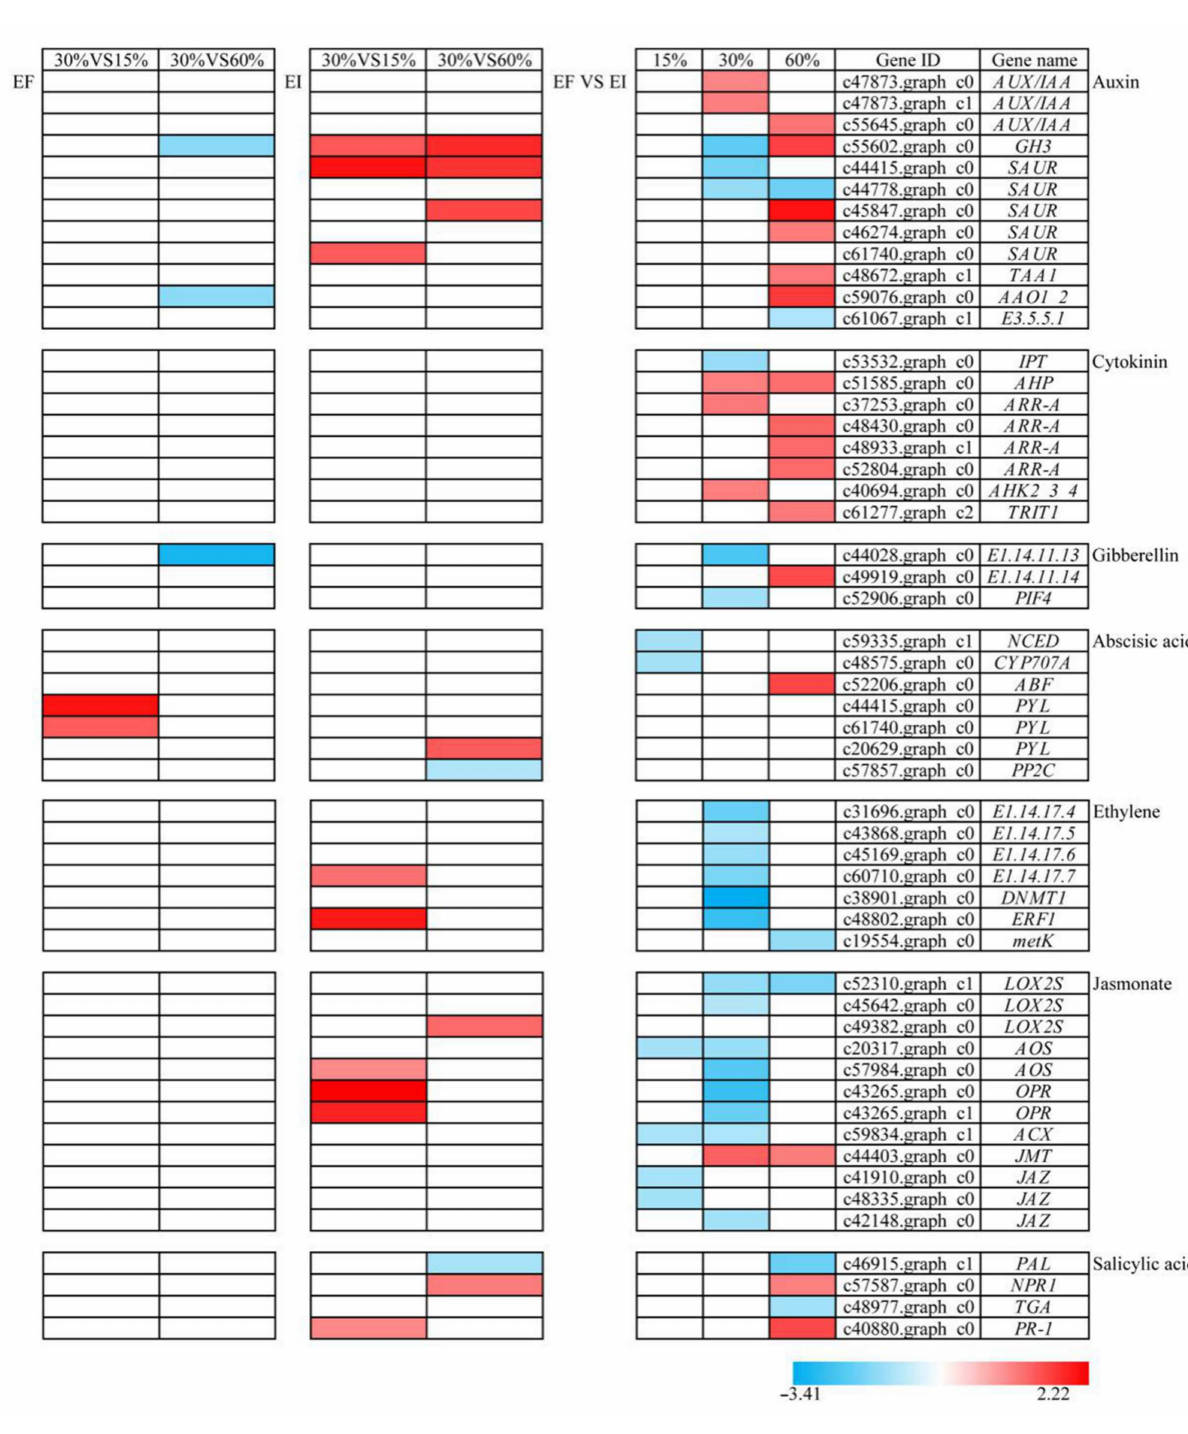
Figure 2. Transcript expression pattern of hormone biosynthesis and catabolism related genes in Achnatherum inebrians under different moisture content and the status of foliar Epichloë gansuensis endophyte (EI: endophyte infected and EF: endophyte free). Color bars ranging from blue to red represent downregulation and upregulation in transcript expression. Gene ID and gene name are